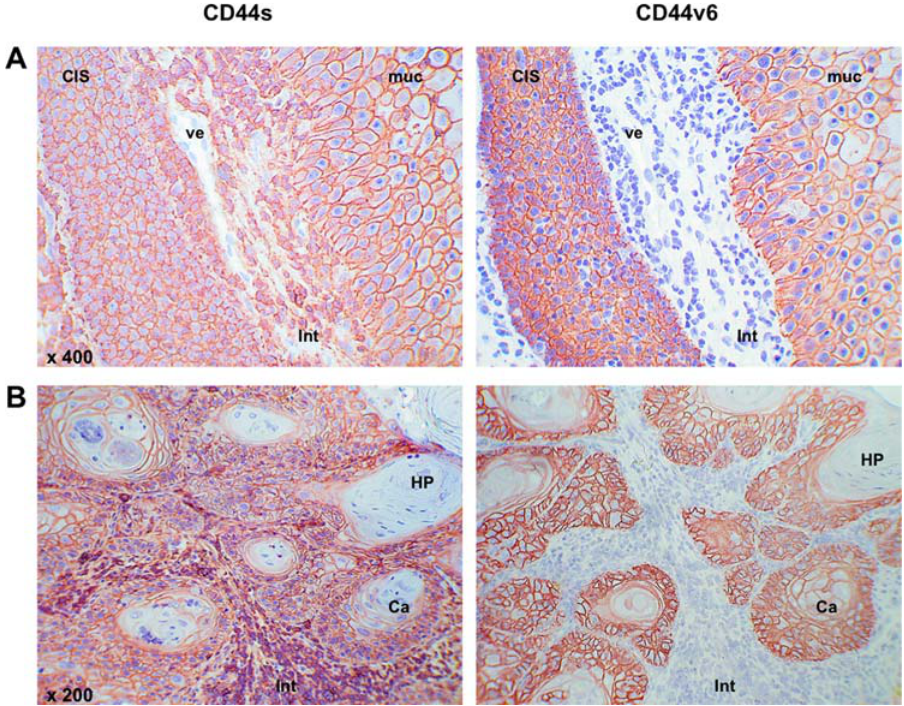
Figure 4. Comparative expression of CD44s and CD44v6 in head and neck epithelia. CD44s and CD44v6 (reddish brown) were visualised in consecutive serial sections of a carcinoma in situ ( A ) and one carcinoma ( B ). Cell nuclei are stained with hematoxylin (blue). CIS : carcinoma in situ ; ve : vessel; muc : mucosa; int : interstitium; ca : carcinoma; HP : horn-pearl forming keratinised tumour cells. Shown are representative sections.